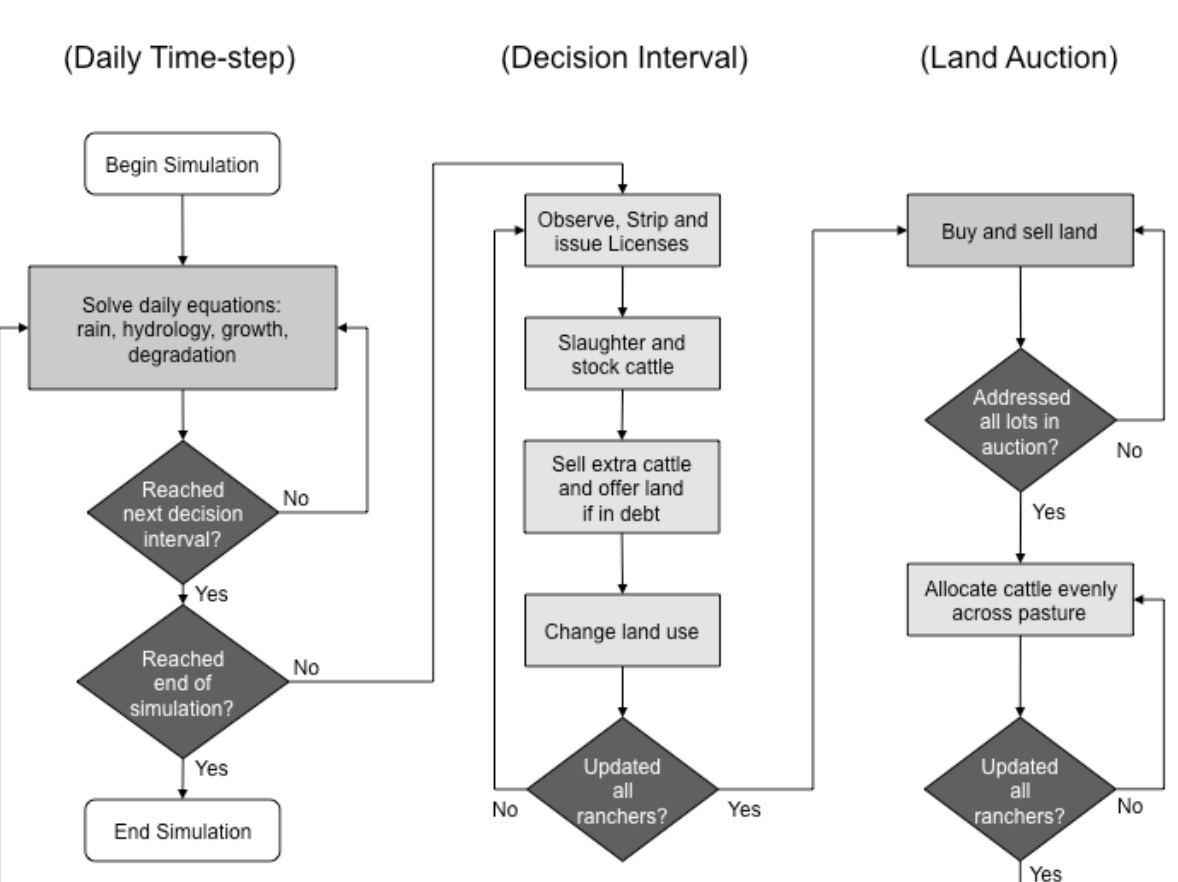
Figure A1.1: Simulation Flow Chart. Processes completed in each daily time-step are shown on the left. Processes occurring at each decision interval (which may be defined to occur at intervals of 1-month, 6- month, 1-year, etc.) are shown in the middle column. Processes tied to the land auction and redistribution of land and cattle (which occurs at the end of each decision interval) are indicated in the right